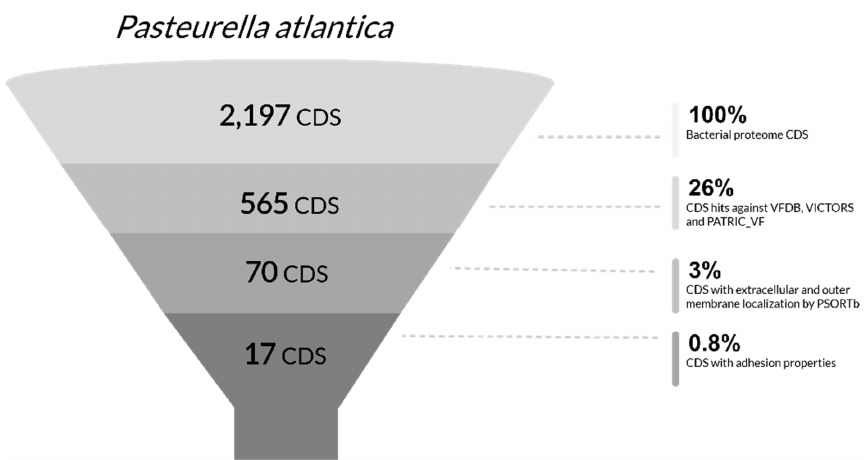
Figure 4. Filtration process of the CDS present in the genome of P. atlantica to determine the most likely virulence factors. According to the selection criteria applied during each step of the process, a total of 17 putative virulence factors were predicted as potentially important contributors to the pathogenicity of P. atlantica. Table 5. Seven extracellular and ten outer membrane localized putative virulence factors of the genome of P. atlantica (NVI 9100). E: extracellular, OM: outer membrane, GI: Genomic island, P: Prophage, and ND: Not designated.